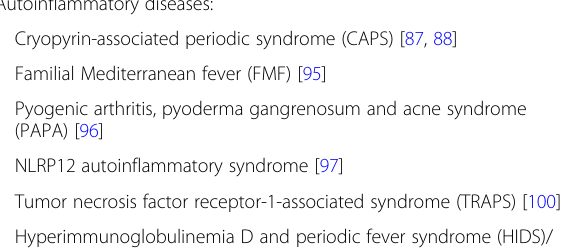
Table 2 Effective anti-IL-1 therapy for inflammatory diseases Autoinflammatory